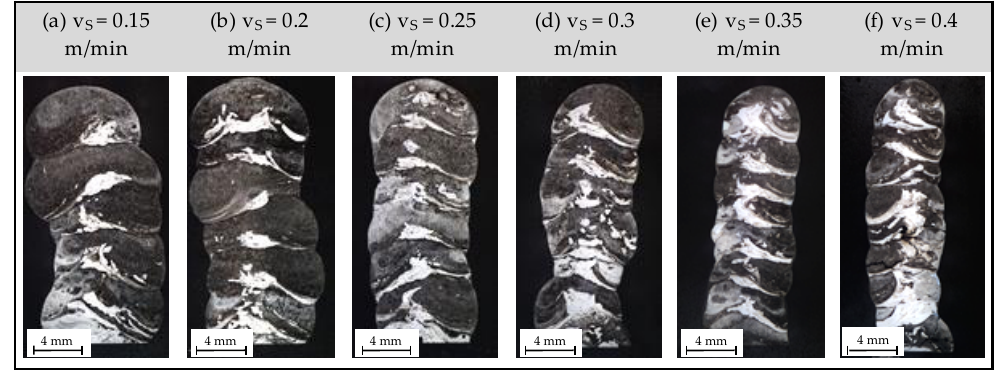
Figure 6. Influence of welding speed on microstructural composition of Ti–47Al alloy; ( a ) 0.15 m / min, ( b ) 0. 2 m / min, ( c ) 0.25 m / min, ( d ) 0.3 m / min, ( e ) 0.35 m / min, ( f ) 0.4 m /